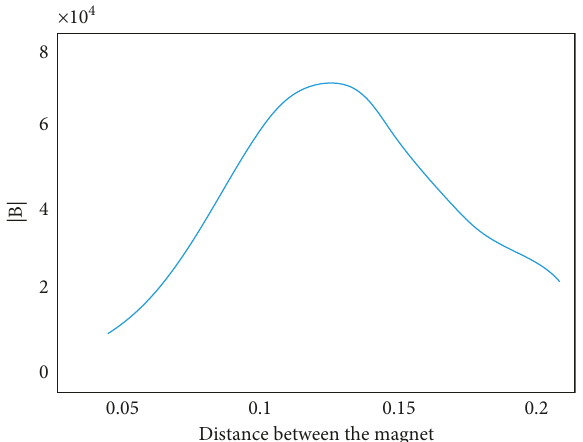
Figure 9: Effect on distortion field strength due to the distance separation between two magnets.